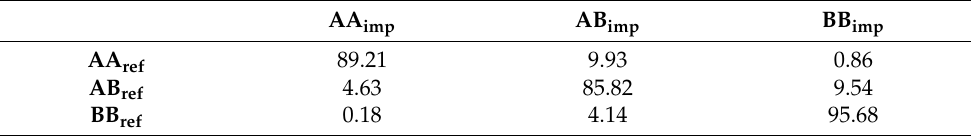
Table 5. Concordance rate in percentage between imputed and real genotypes with a reference panel of 88 purebred Hanwoo.